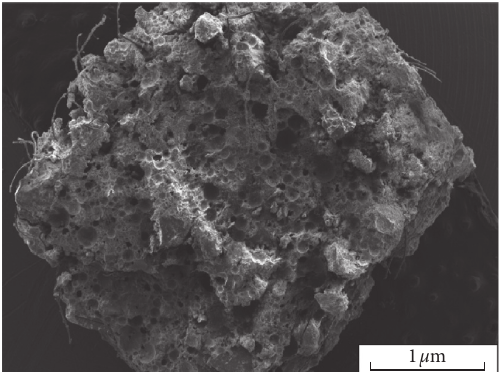
Figure 19: Surface topography of concrete mixed with rubber and